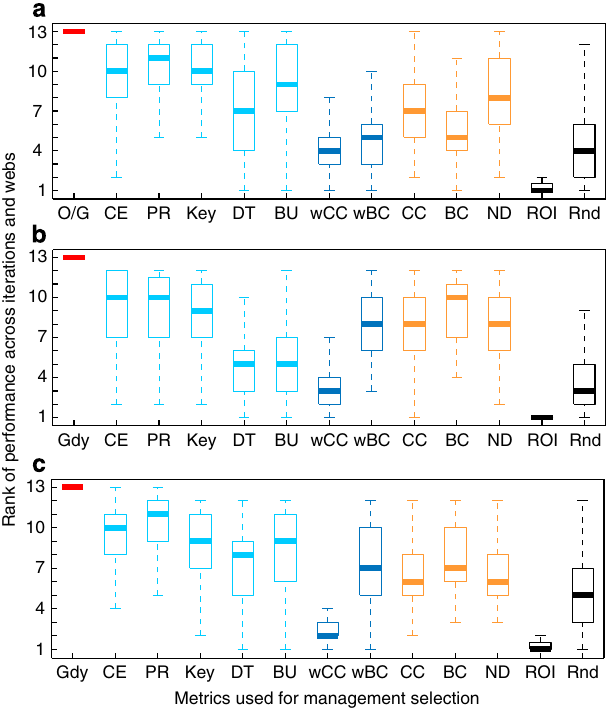
Figure 2 | Rank of management performance given a budget of 25% required to manage all species in the food web. Rank is across 100 simulations of extinction risk (drawn from a Beta distributionwith a ¼ 2 and b ¼ 8) and interaction strengths (drawn from a lognormal distribution with log-mean—3.0 and log-s.d.—1.5) for six real webs ( a ), and across all 10 iterations for 20 hypothetical food webs with connectance of 0.1 ( b ) and 0.2 ( c ). Extinction risk with management is zero. The greedy approach is used for large food webs ( n 4 14) instead of the optimal strategy. Standard competition ranking is used and ten is the best ranking. The center value is the median, the edges of the box the 25th and 75th percentiles, and the whiskers represent þ / (cid:2) 1.5 the inter-quartile range. Black, naı¨ve; orange, interactions; dark blue, interactions and strengths; light blue, interactions and trophic structure; red, all complexities. BC, Betweenness Centrality; BU, Bottom-Up Prioritization; CE, Cascading Extinction; DT, Dominator Tree; Gdy, Greedy approach; Key, Keystone Index; ND, Node Degree; O/G, Optimal or Greedy; PR, modified Google PageRank; Rnd, Random strategy; ROI, Return-On-Investment; wBC, weighted BC; wCC, weighted CC.